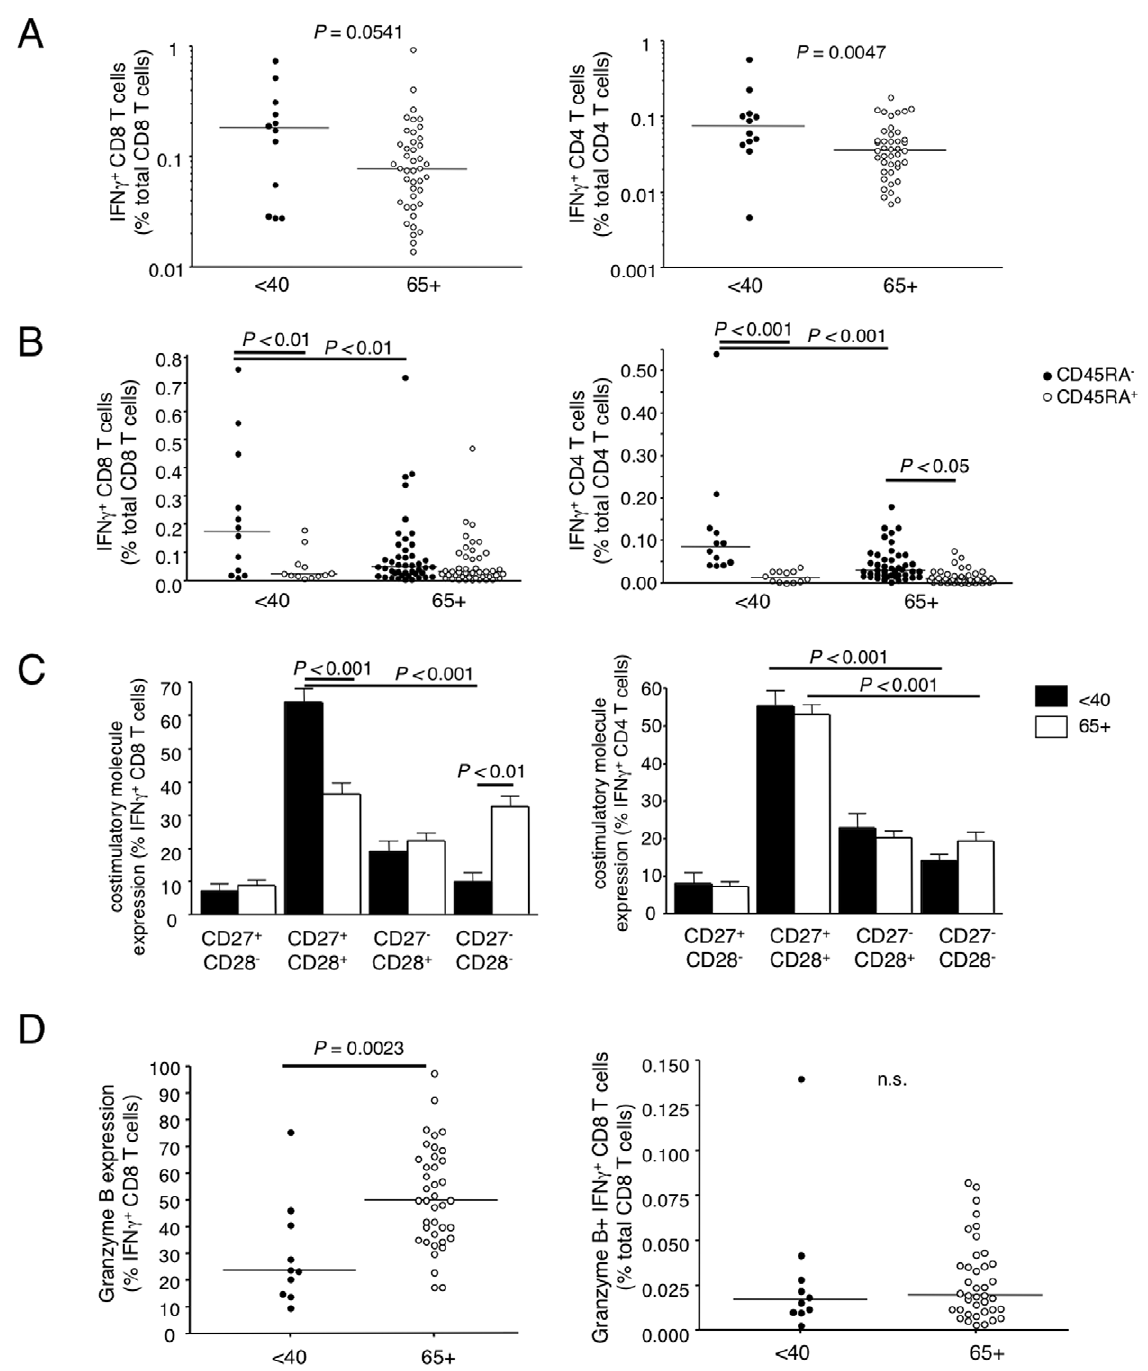
Figure 2. Older donors have fewer influenza-responsive T cells prior to vaccination and a higher proportion of these T cells are of a late effector phenotype than those in younger donors. PR8-stimulated T cells were phenotyped for memory and effector T cell markers CD45RA, CD28, and CD27 in young, under 40 and older, 65 + donors. CD8 T cells were also examined for granzyme B expression after stimulation (flow cytometry gating as in Figure 1). (A) Proportions of influenza functionally responsive CD8 ( left ) and CD4 ( right ) T cells out of total CD8 and CD4 pools. (B) Division of influenza responsive CD8 and CD4 T cells into CD45RA 2 memory and CD45RA + late effector cell subsets. (C) Costimulatory molecule expression profiles in young and older donors in influenza responsive CD8 and CD4 T cells. (D) Granzyme B expression within the influenza responsive IFN c + CD8 T cell subset ( left ) and overall proportions of granzyme B + IFN c + CD8 T cells out of the total CD8 T cell population ( right ). doi:10.1371/journal.pone.0023698.g002 As co-expression of KLRG1 and CD57 are thought to mark senescence markers with the donor’s ability to produce IFN c in senescent CD8 T cells, we analyzed the correlation between the response to 18h PR8 virus stimulation (Fig. 3C). A negative proportion of the tetramer + cells which were dual positive for correlation was found in older HLA-A2 donors between the